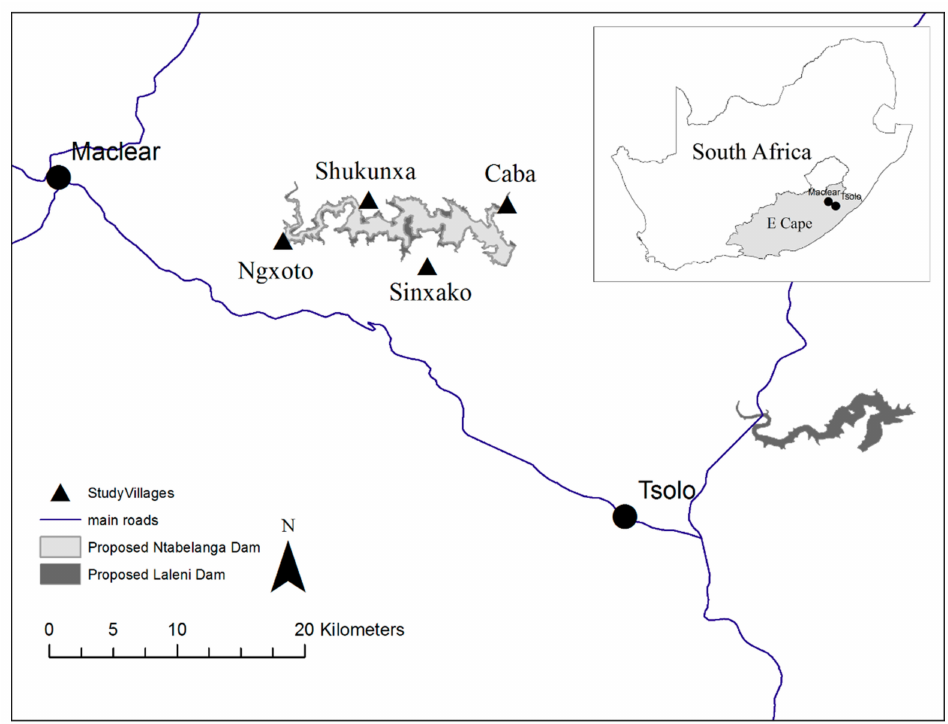
Figure 2. Location of case study two: the Mzimvubu Water Project and the Tsitsa